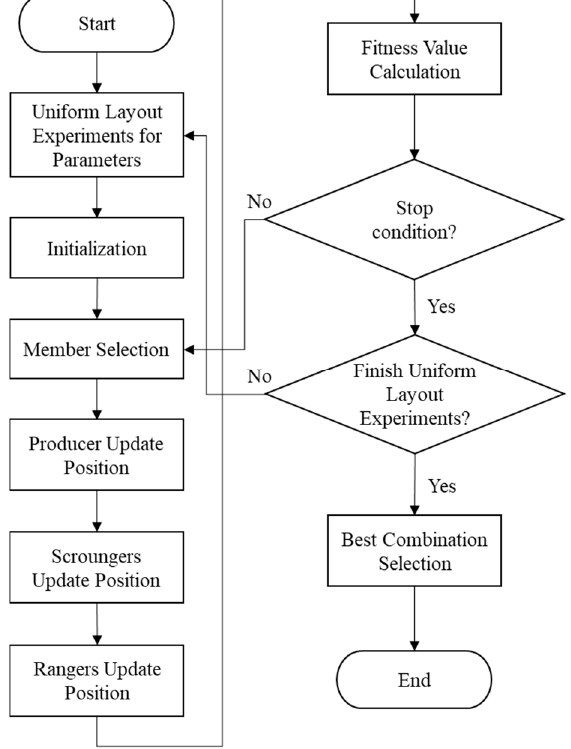
Figure 3. Flowchart of parameter optimization procedure for the GSO algorithm when using the uniform layout.